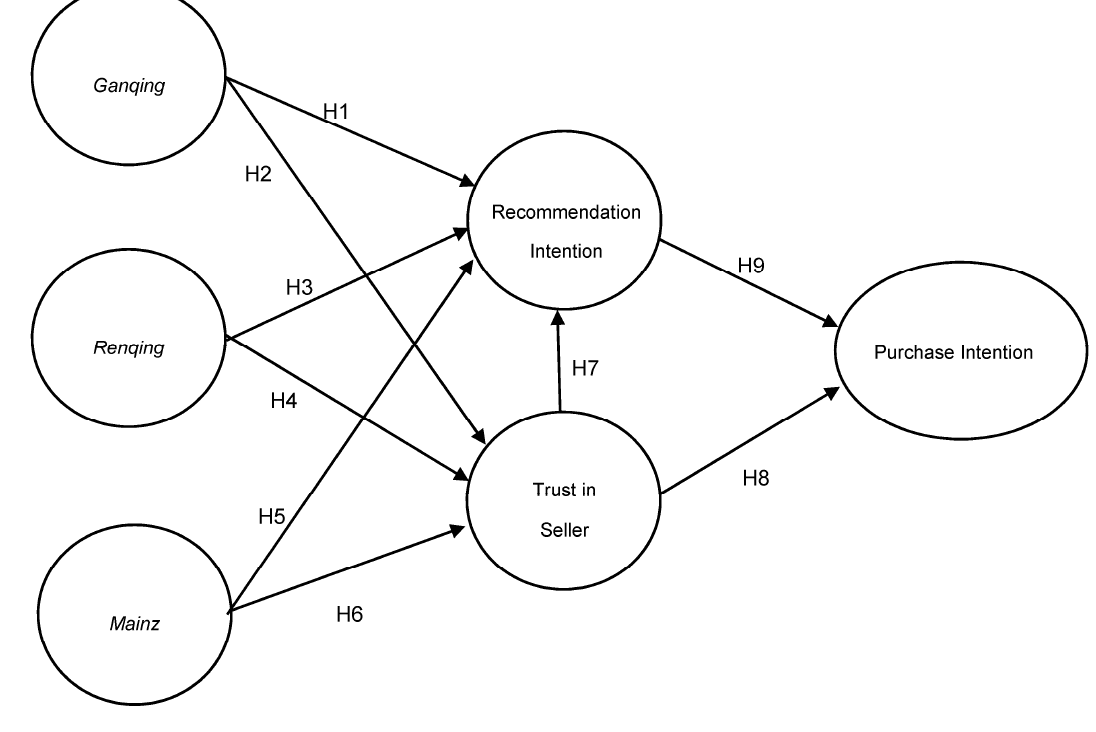
Figure 1. Research model.